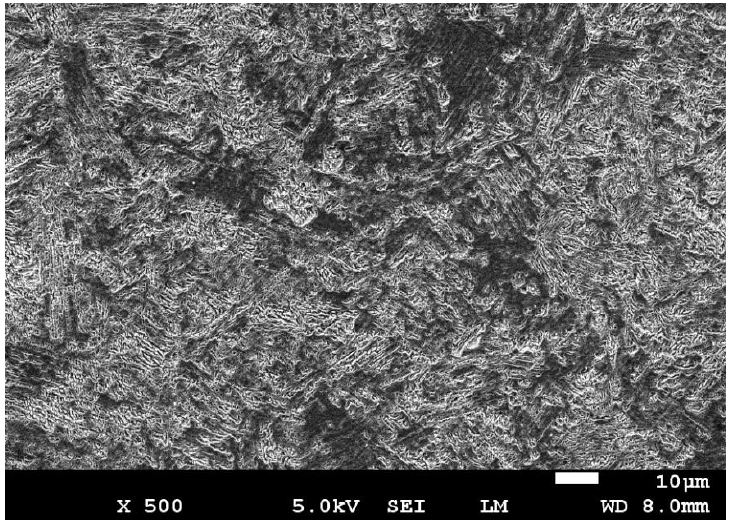
Figure 3. Microstructure of the surface of the fabricated γ-TiAl